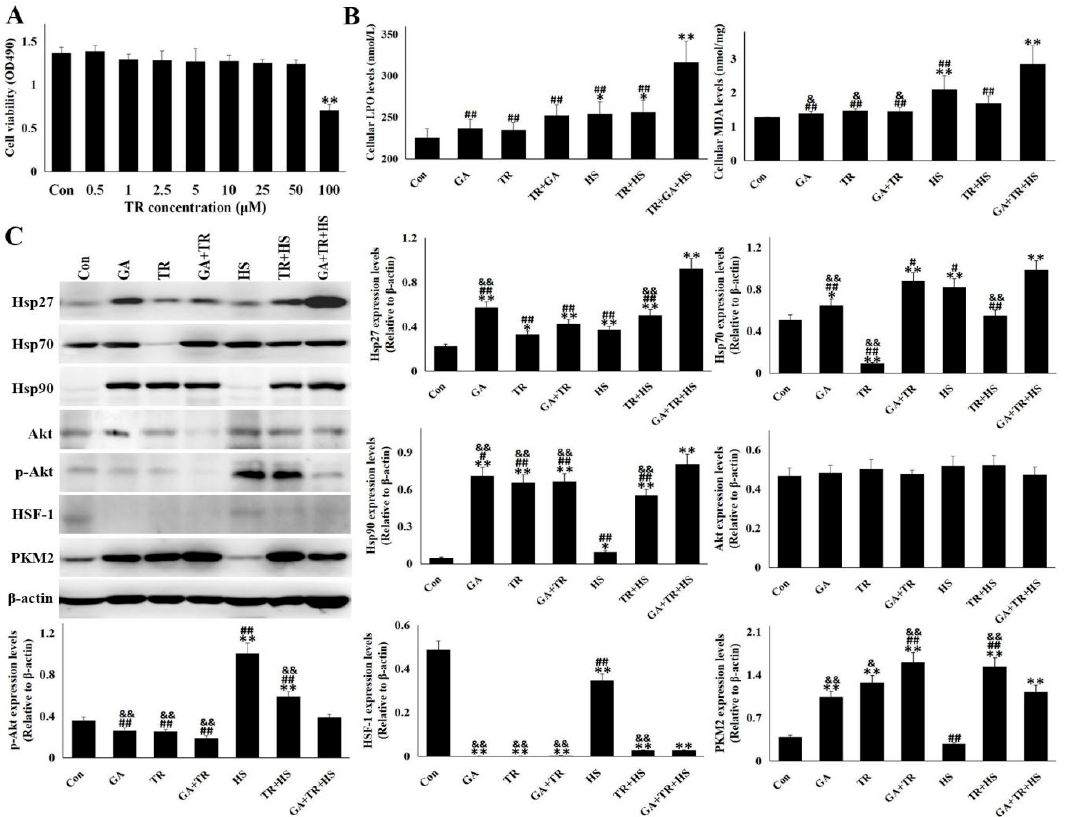
Figure 5. PKM2 was an alternative pathway under the deficiency of Hsp90 function and Akt phosphorylation. Data represent the means ± SD for three independent experiments. ( A ) After treatment with triciribine of different concentrations for 24 h, CCK-8 tests were used to detect cell viability. ( B ) After treatment with triciribine of 50 µm for 14 h, cells were exposed to heat stress for 5 h or not for detecting LPO and MDA levels. ( C ) After treatment with triciribine of 50 µm and/or 0.1 µM GA for 14 h, cells were exposed to heat stress for 5 h or not. Western blot analysis was used to detect the levels of different proteins with the indicated antibodies. Representative bands are presented in the left panel. Reactive bands were quantified using the Quantity One software, and the relative abundance of the tested proteins was normalized to that of β -actin (right panel). The differences of the data of cells with different treatment vs. that of the Con are indicated by * p < 0.05 and ** p < 0.01. The differences of the data of cells treated by TR + GA + HS vs. that in other groups are indicated by # p < 0.05 and ## p < 0.01. The di ff erences of the data of cells in HS vs. that in other groups are indicated by & p < 0.05 and && p <